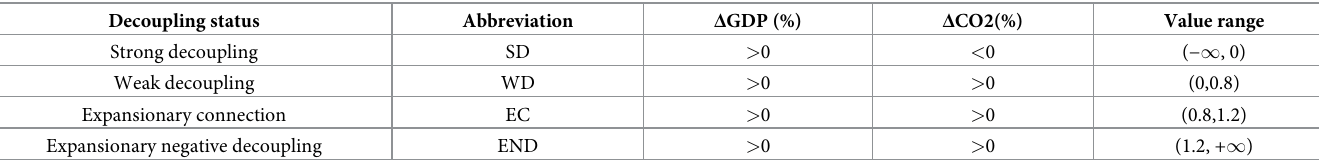
Table 1. Division basis of decoupling status.